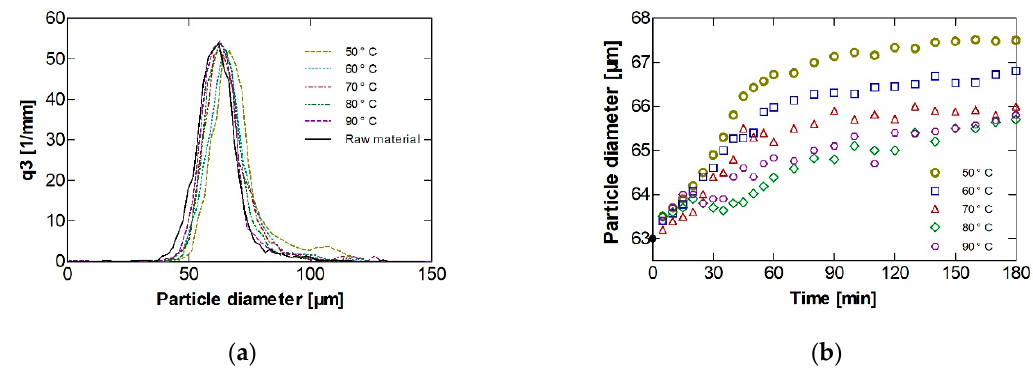
Figure 9. ( a ) Particle size distributions, and ( b ) evolution of average particle diameter d 1,3 at di ff erent temperatures.